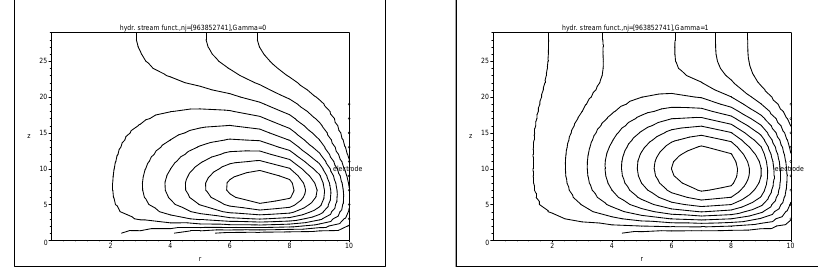
Figure 11. The stream functions for nj = [478591623] , ψ ∈ (0 . 00 , 0 . 26) , Γ = 0 .